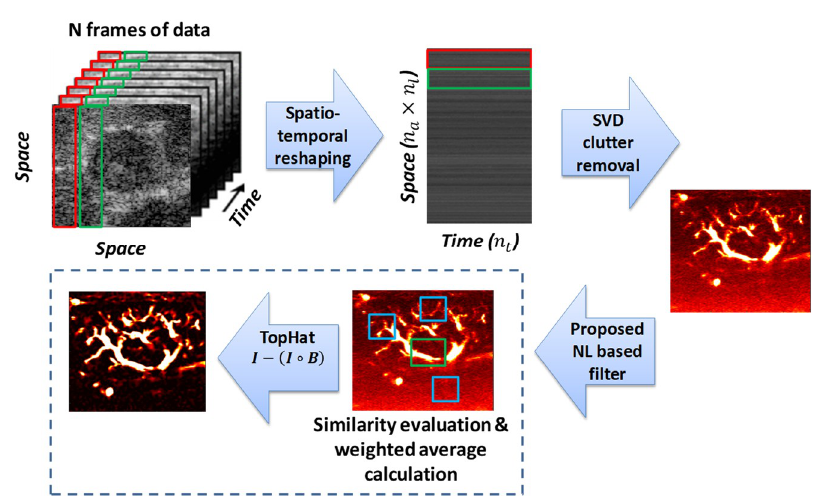
Figure 1. Schematic diagram of the proposed filtering framework. SVD—singular value decomposition.